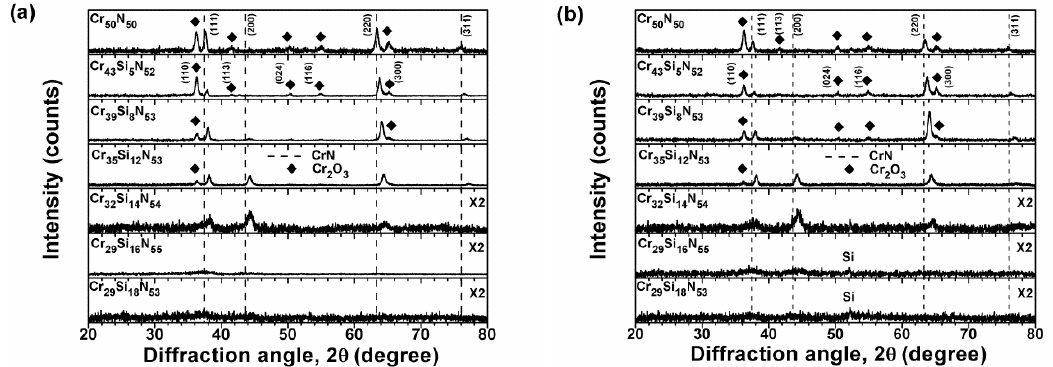
Figure 8. XRD patterns of Cr–Si–N coatings annealed in 15 ppm O 2 –N 2 at 600 °C for ( a ) 8 h and ( b ) 16 h (×2: multiplied by 2).